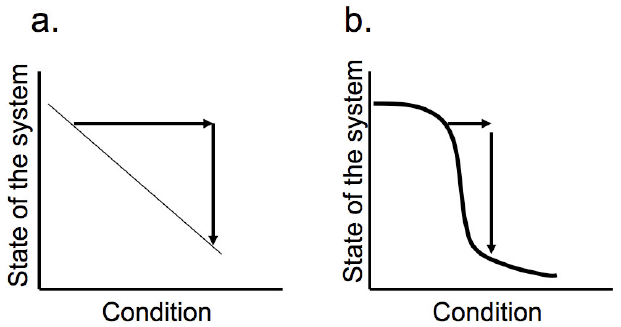
Fig. 1 . Change in the state of the system as a function of the underlying determining conditions. a. A linear response in which a large change in the system results only from a large change in the conditions. b. A nonlinear response in which a large change in the system may result from only a small change in the conditions (after Scheffer 2009).